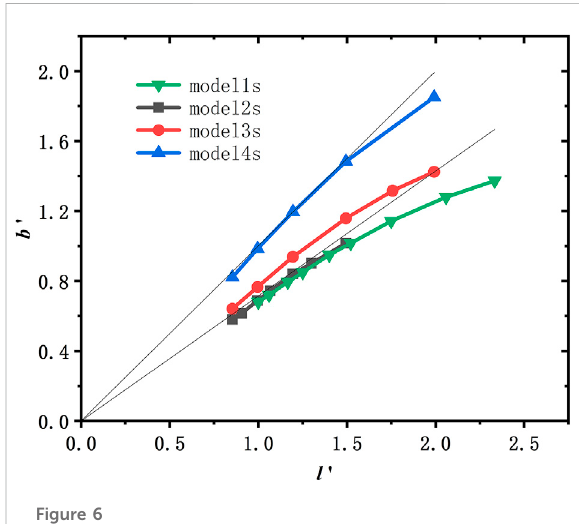
Figure 7 Fitting result for κ (cid:1) f ( h ’ ) using an exponential function.